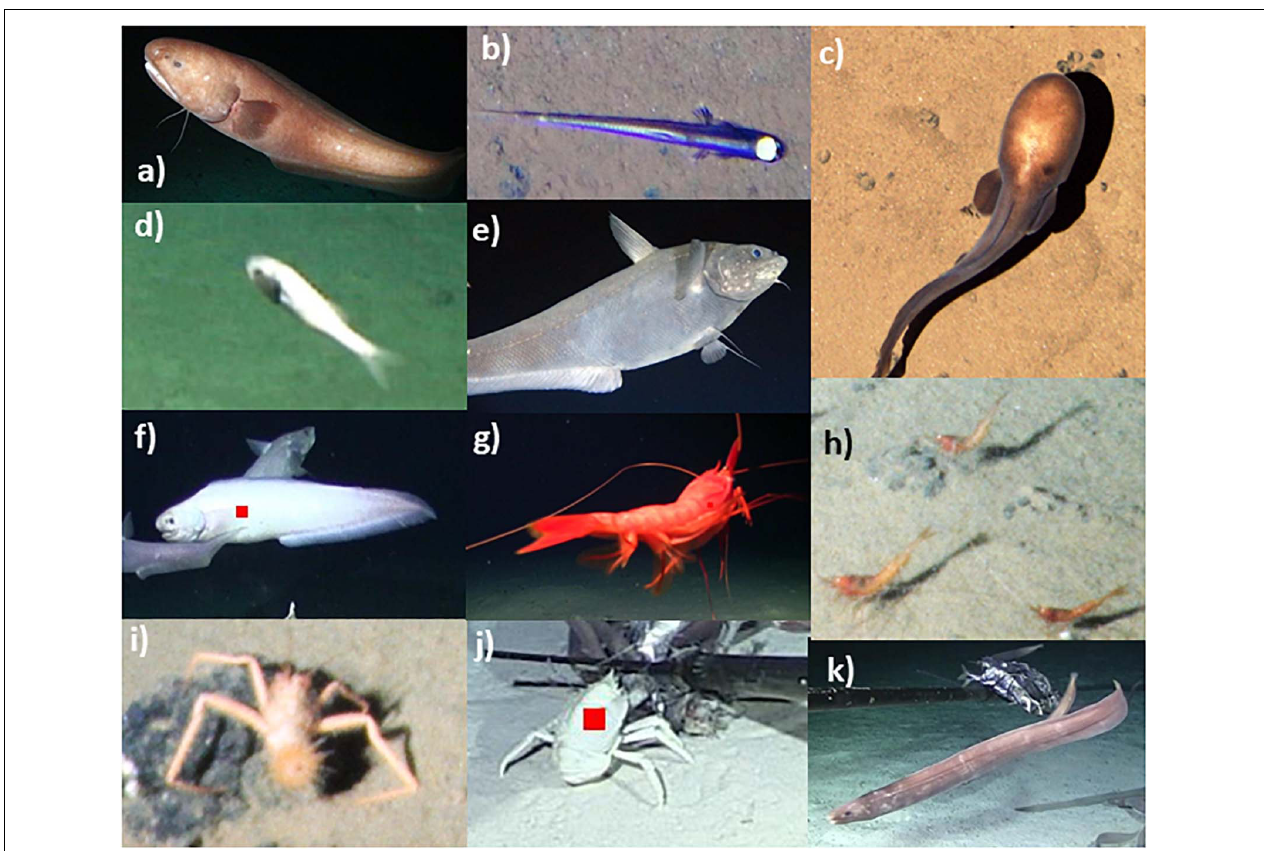
FIGURE 4 | Representative fishes and invertebrate scavengers observed in visual transects and baited cameras. (a) Bassozetus cf. nasus , (b) Ipnops meadi , (c) Typhlonus nasus , (d) Abyssoberyx sp., (e) Coryphaenoides armatus/yaquinae , (f) Barathrites iris , (g) Cerataspis monstrosus , (h) Hymenopenaeus nereus , (i) Probeebei mirabilis , (j) Munidopsis sp., (k) Ilyophis arx